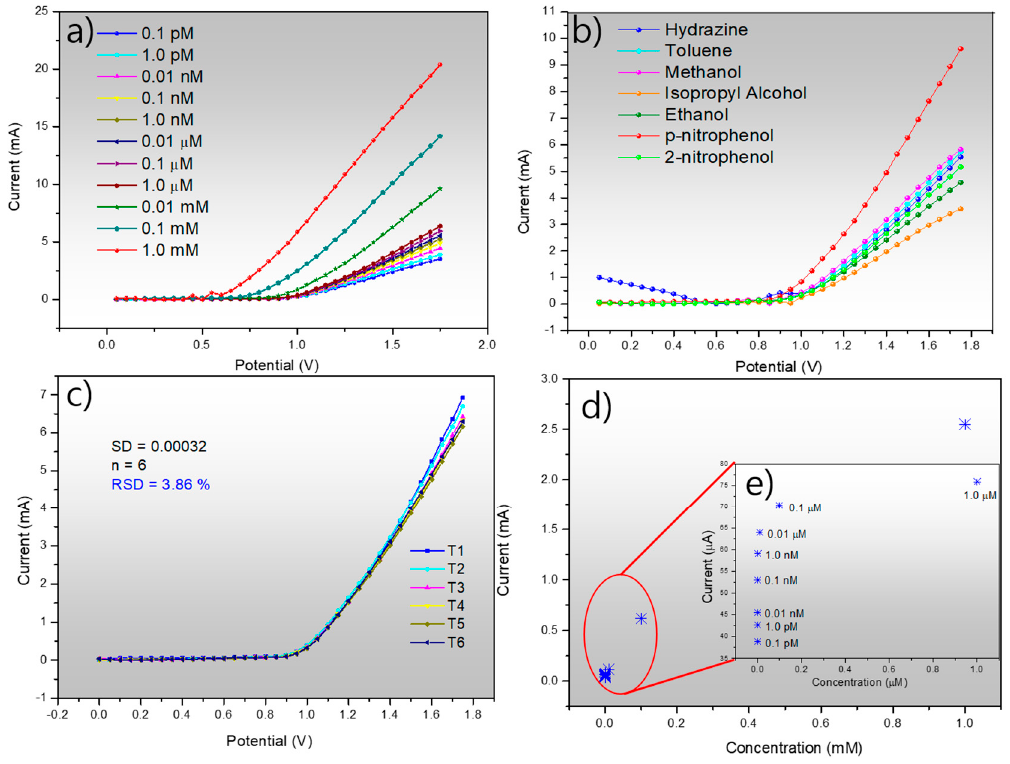
Figure 8. ( a ) Electrochemical detection of p -nitrophenol using Ag 2 ONP–C/NFE at different